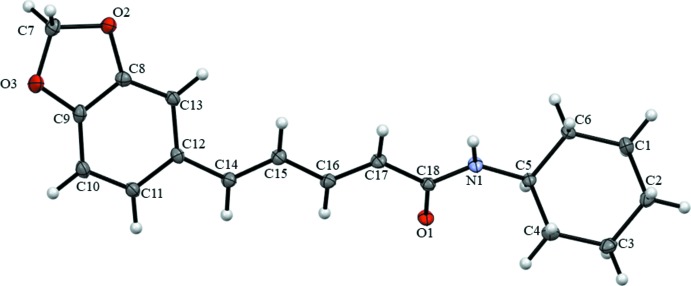
Displacement ellipsoid drawing at a 50% probability level of the asymmetric unit of (I).